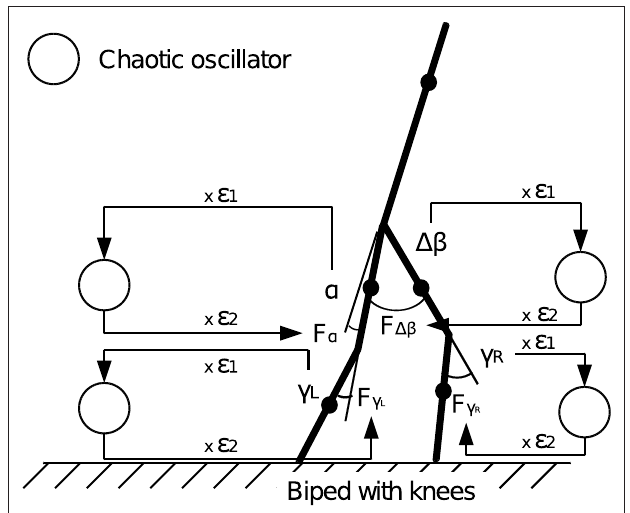
FIGURE 8 | Control scheme of the kneed biped. Each joint is linearly coupled to a chaotic unit receiving in return its joint angle. The sensory inputs are pondered by the coupling parameter ε , and the motor outputs are 1 weighted by ε . Hence, the pair { ε , ε } controls the whole biped’s dynamics. 2 1 2 The limbs coordination arise when the isolated chaotic units globally phase synchronize to each other through the body.